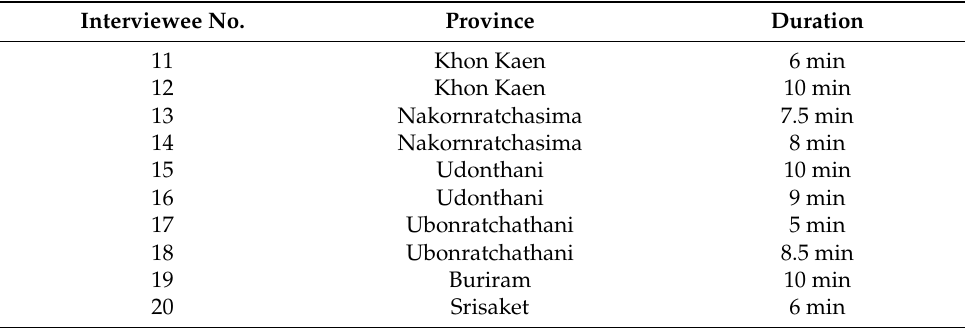
Table A2. Interviews and Interviewees of Thai Participants: Segment 2. Interviewee No.